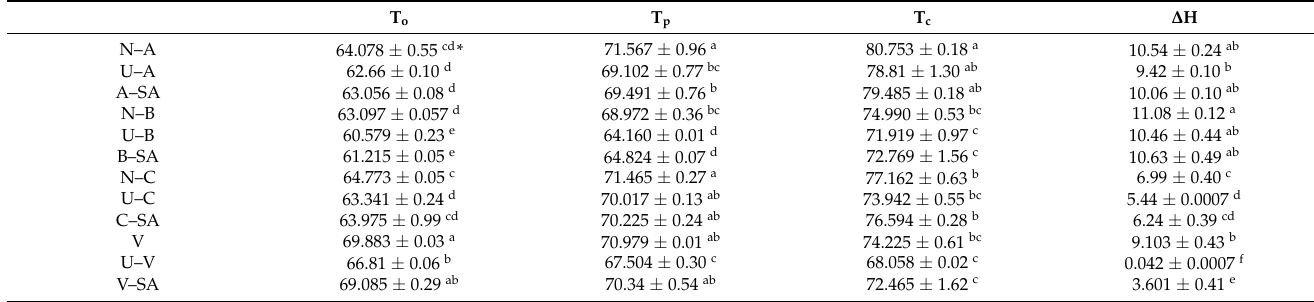
Table 1. DSC parameters for natural A–, B–, C–, V–type starches (N–A, N–B, N–C, V),